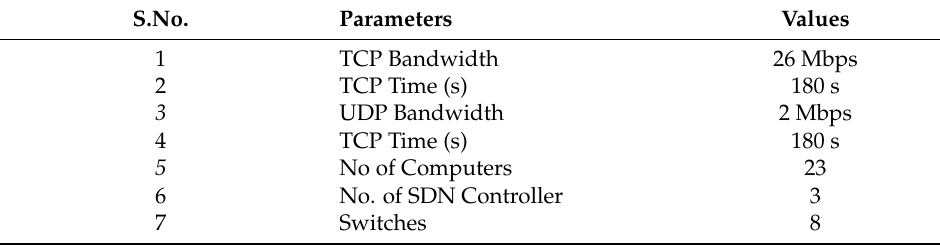
Table 3. Parameters used in Multi-controller topology.